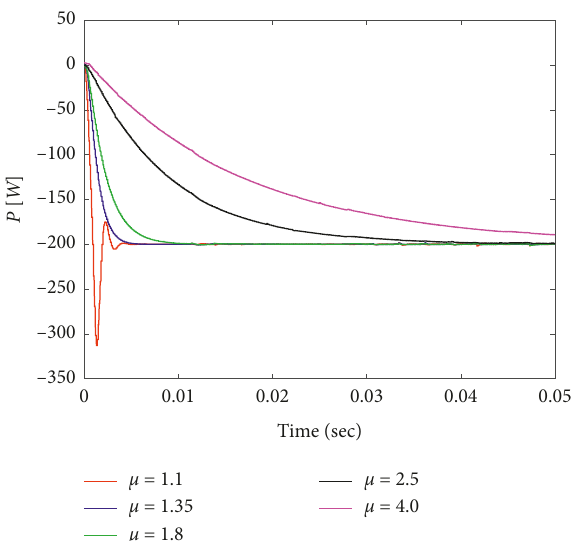
Figure 11: Active power using different uncertainties range µ in discharging mode. Step 5: If the closed-loop system shows serious over- shoot or becomes unstable, then adjust the uncertainty